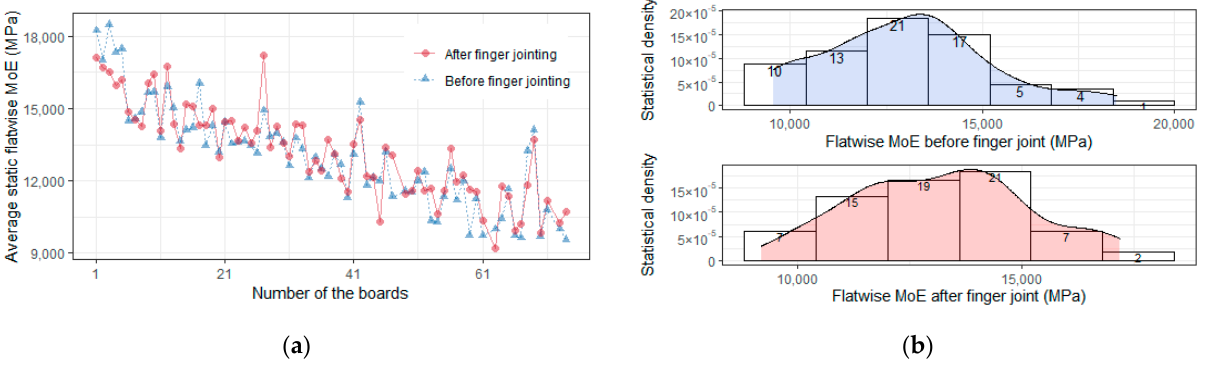
Figure 7. ( a ) Flatwise MoEs of the boards before and after finger jointing; board number 1 had the highest mean value of flatwise MoE (14~17 sections) before finger jointing. ( b ) Histogram plots of flatwise MoEs before and after finger jointing.